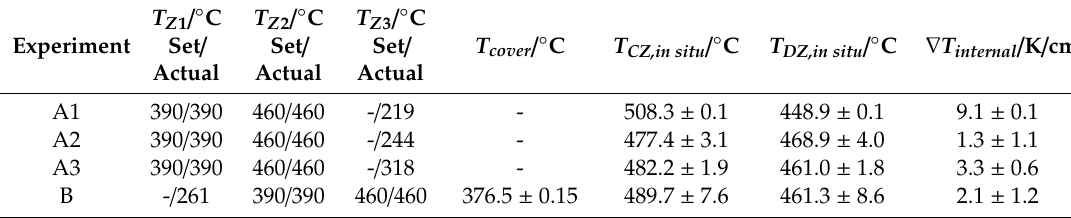
Table 5. Summary of experimentally determined temperature distributions. The amplitude of temperature fluctuations is given as a plus- / -minus-range that follows the average value. For an illustration of the locations of measurement see Figure 1. Data mostly taken from [21]. T cover refers to the temperature measured by a thermocouple placed in a relief hole in the top part of the autoclave close to the connection to the head